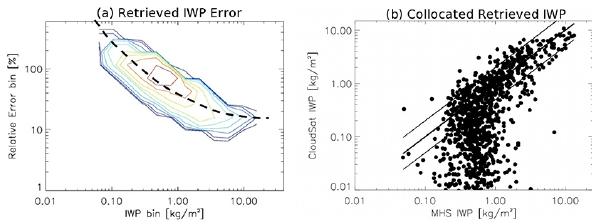
√ S IWP / IWP, %) of one- Figure 10. (a) PDF of relative error ( month retrieved IWP between 30 ◦ S and 30 ◦ N. Contours are in log scale. The peak of the PDF is roughly marked by hand to rep- resent an exponential decrease (thick dashed line). (b) Collocated CloudSat-MHS IWP retrievals for July 2010 within the same lati- tude band. The thick solid line is the 1:1 line, and the other two thin solid lines mark the 1:2 and 2:1 ratios,